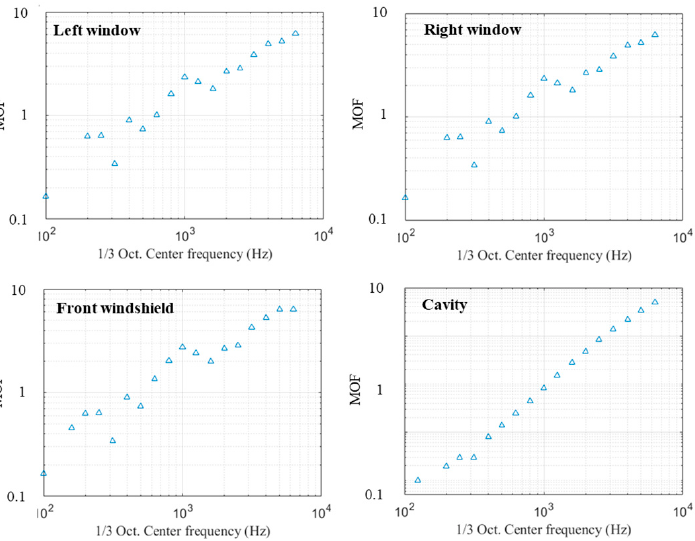
Figure 13. Modal overlap factors of side windows, front windshield, and cavity.